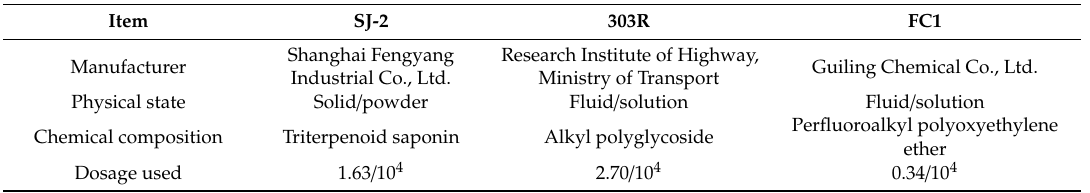
Table 3. Air-entraining agent (AEA) information.